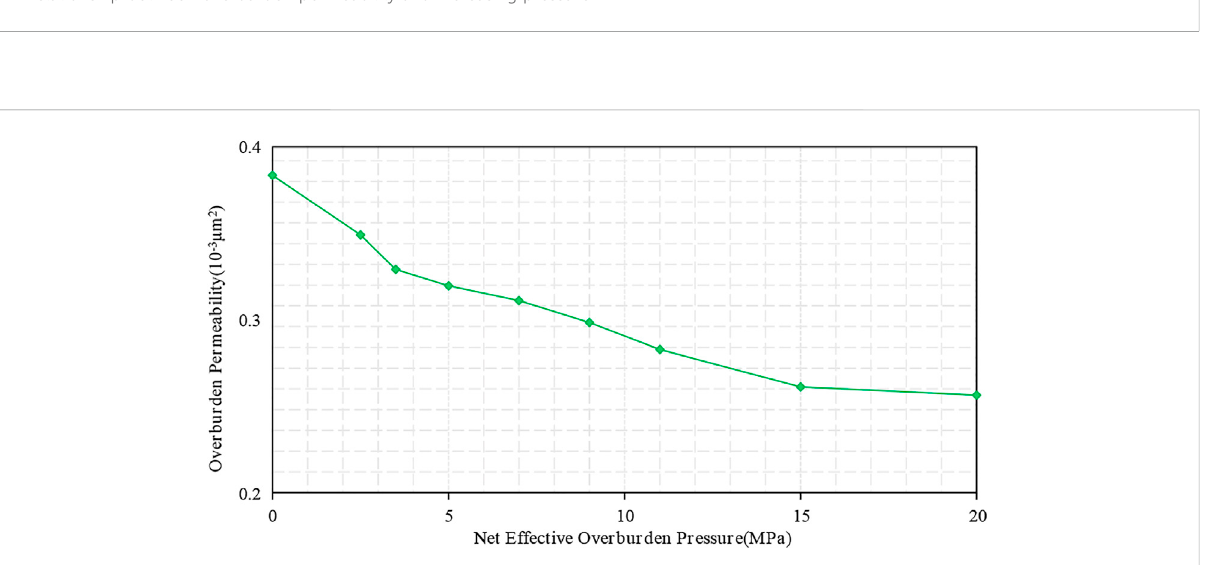
Relationship between overburden permeability and increasing pressure.